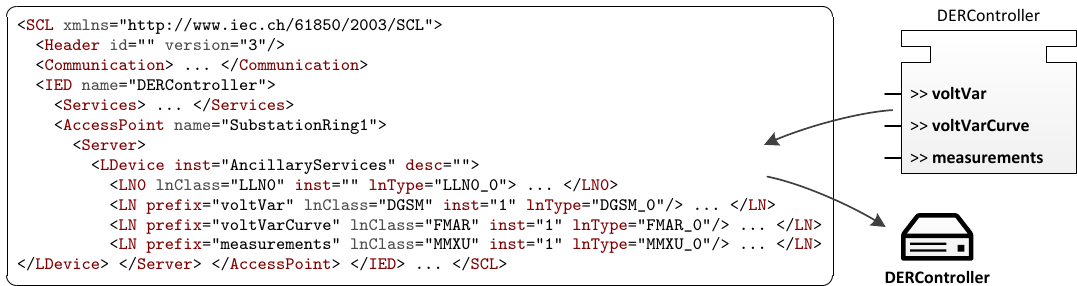
Figure 14. Generated System Configuration Language (SCL) file for configuration of the IEC 61850 server in DERController .